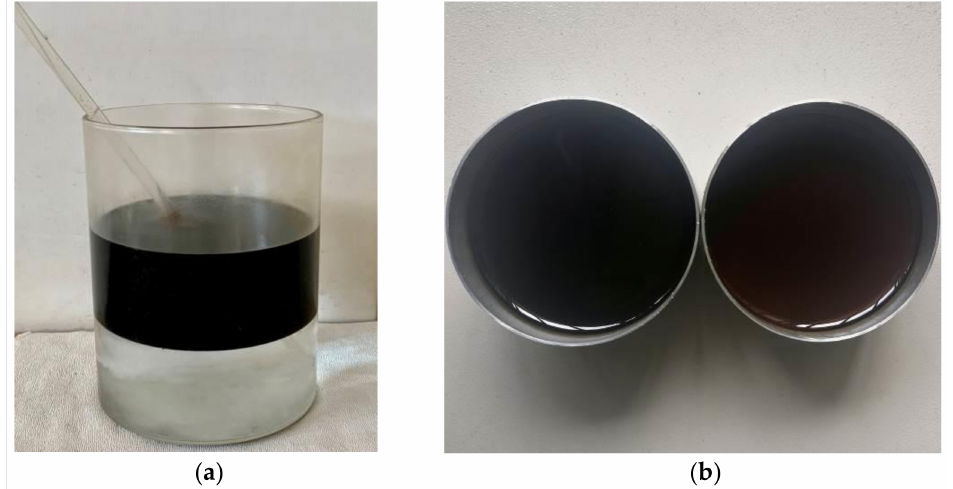
Figure 2. Pretreatment of bio-oil. ( a ) Mixing of water and oil; ( b ) Bio-oil before and after treatment.